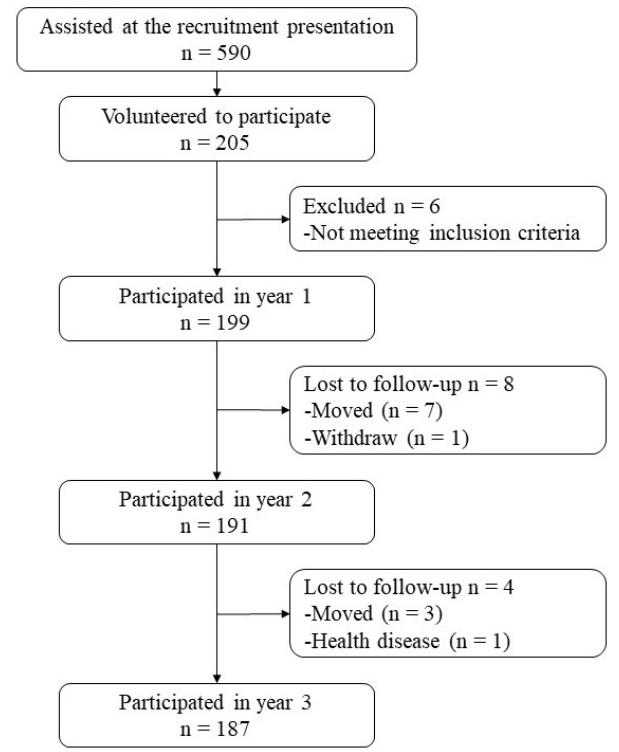
Figure 1. Participants flowchart.